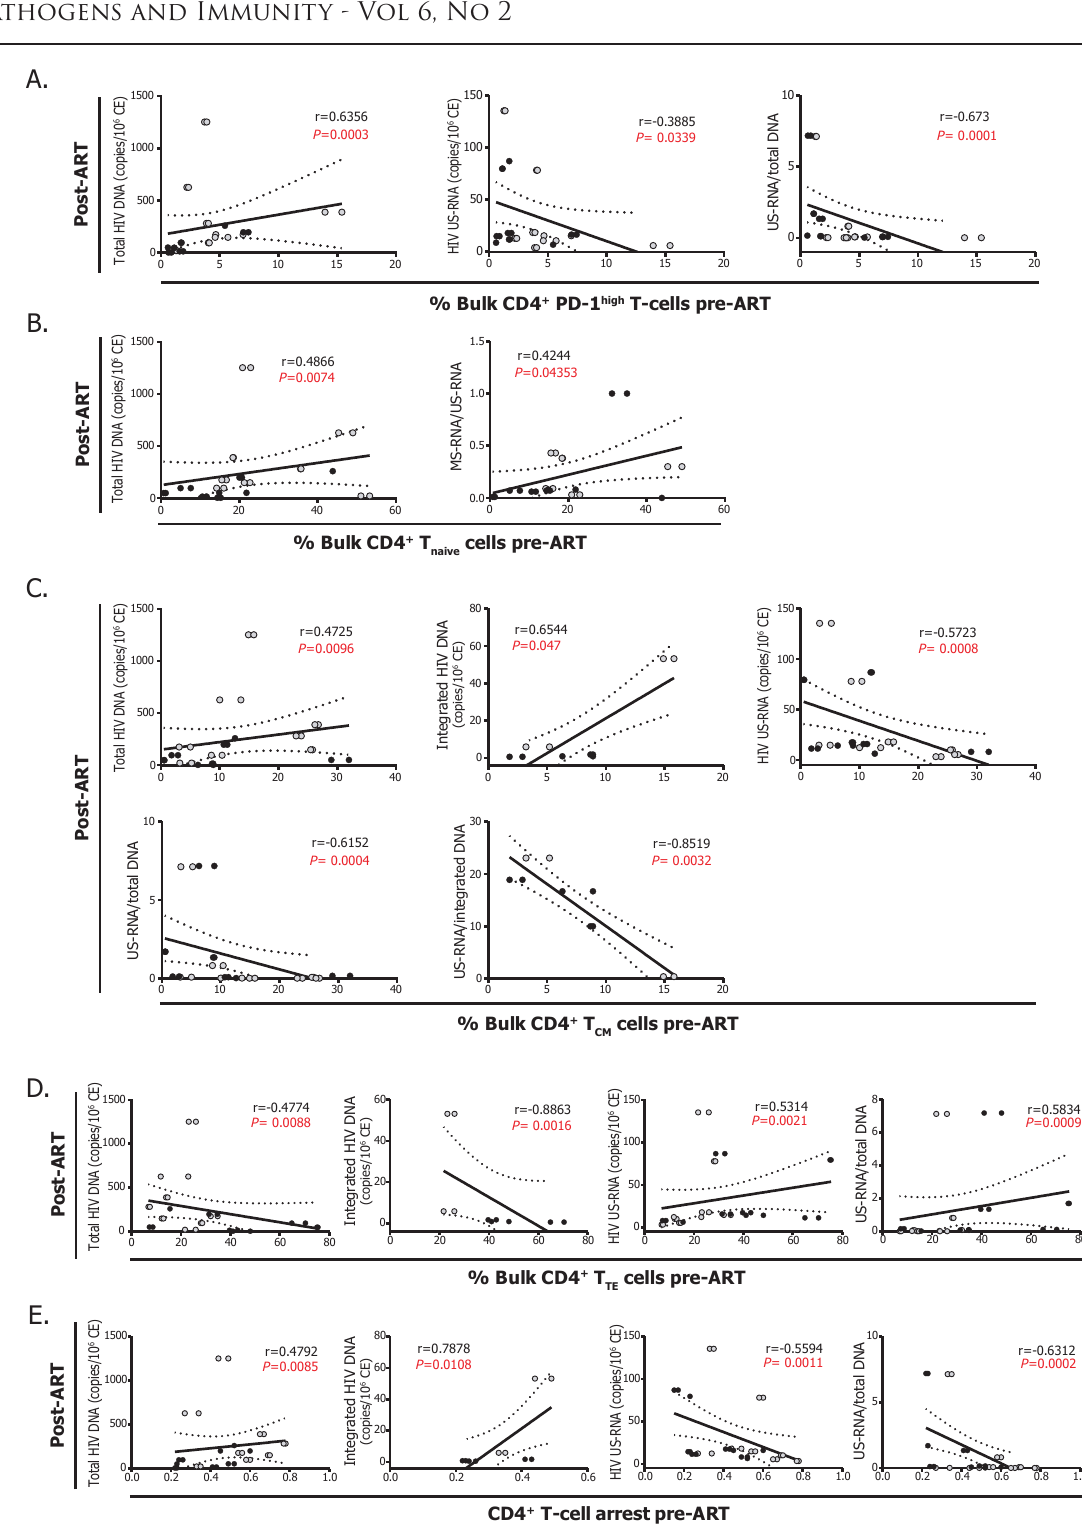
Figure 3: Correlation analysis between the phenotype of CD4+ T cells pre-cART and HIV persistence A. Correlations between the proportions of CD4+ T cells expressing PD-1 high pre-cART and the levels of total HIV DNA, US-RNA, and US-RNA/total DNA ratios. B. Correlations between the proportions of CD4+ T